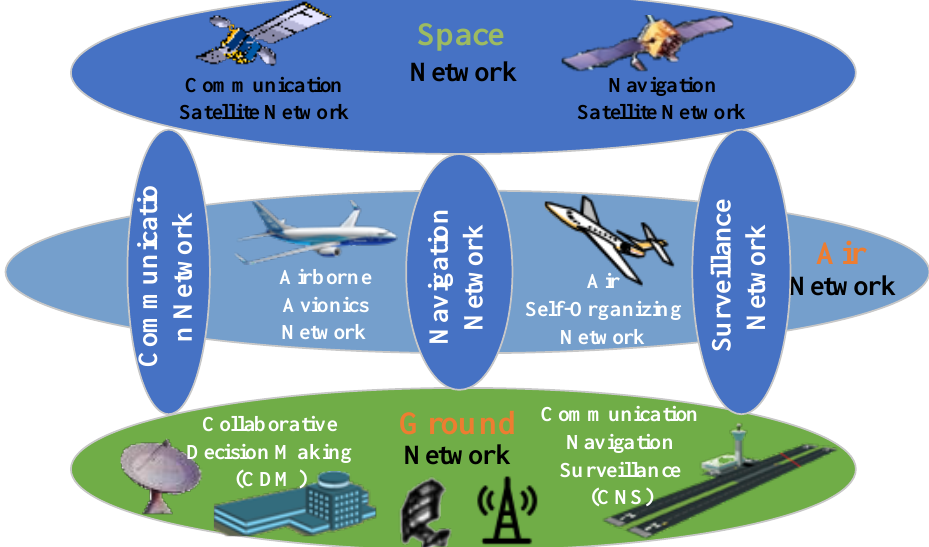
Figure 1. Networked ATM system with space–air–ground structure.